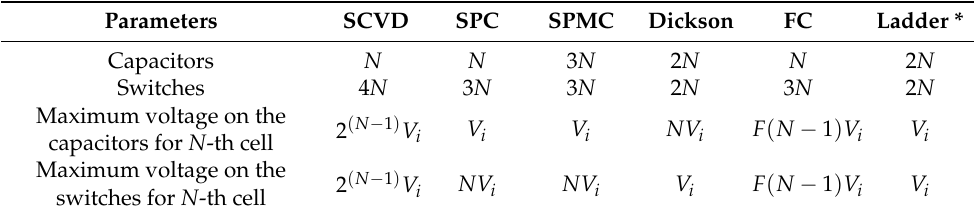
Table 5. Comparison among SC topologies. Parameters SCVD SPC SPMC Dickson FC Ladder *